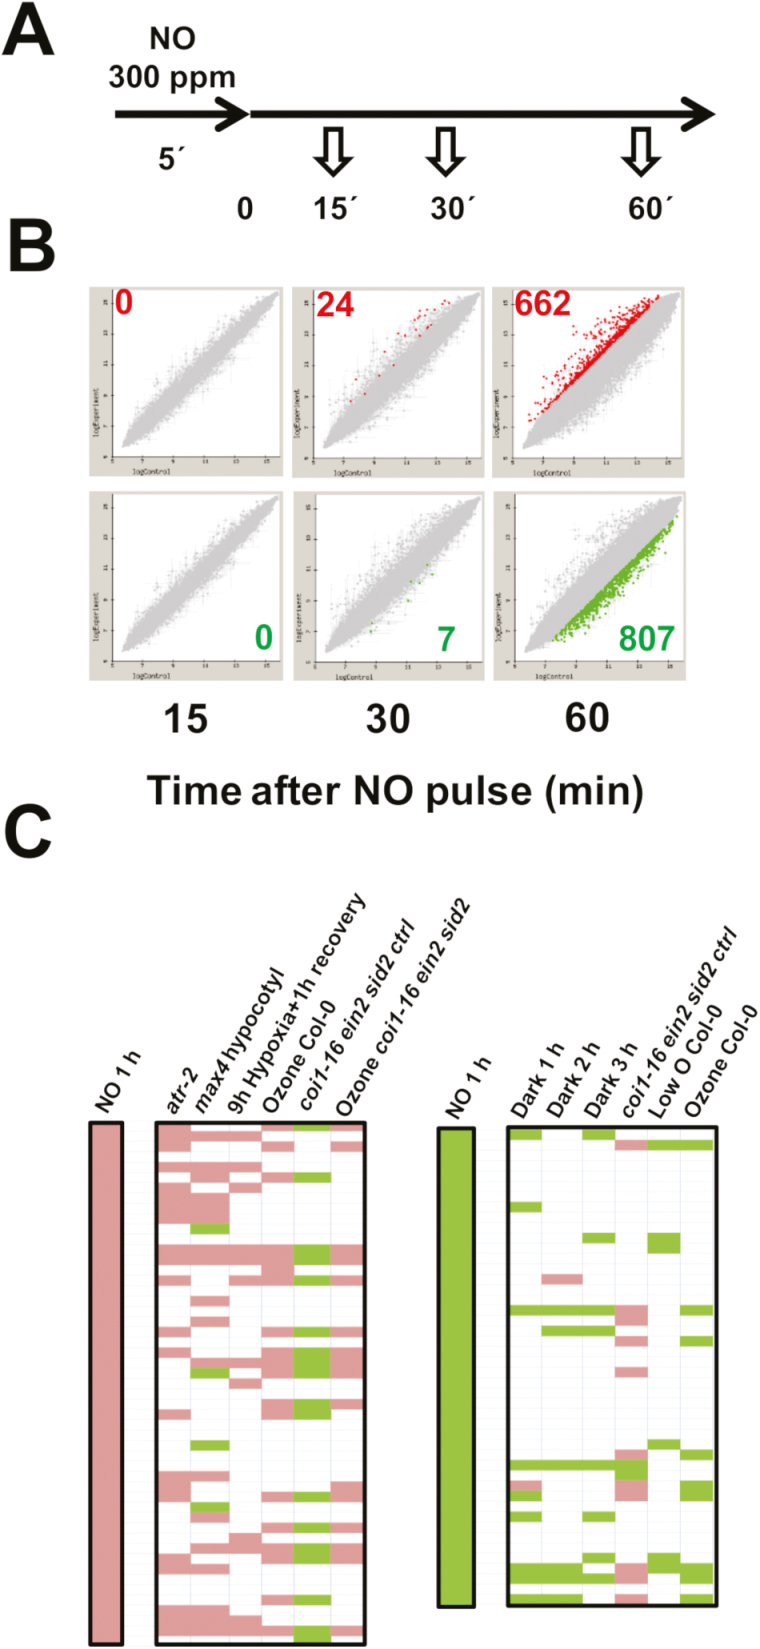
Identification and characterization of the NO-responsive transcriptome. (A) Experimental scheme of sampling. (B) Plots representing the up-regulated (dots in the upper panel) and down-regulated (dots in the lower panel) genes at the indicated times after exposure to NO. (C) AtCAST3.1-based comparison of the up- and down-regulated transcriptomes at 1 h after exposure to NO with publicly available hormone- and redox-related transcriptome data sets.